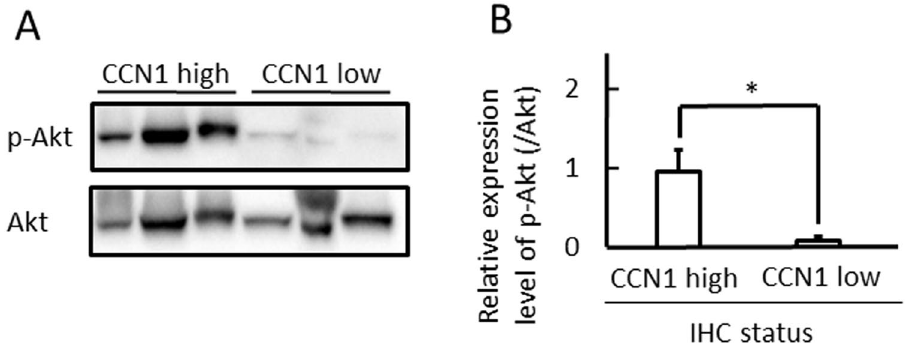
Figure 5. PI3K/AKT/mTOR pathway is upregulated in CCN1 high expression group. ( A ) Immunoblot analysis of levels of p-Akt and Akt total protein in CCN1 high and low expression cases. ( B ) Quantification of data from panel A. Statistical significance was calculated by the Student’s t -test. * p < 0.05. Data are shown as the mean ± SEM. Full-length blots are presented in Supplementary Figure